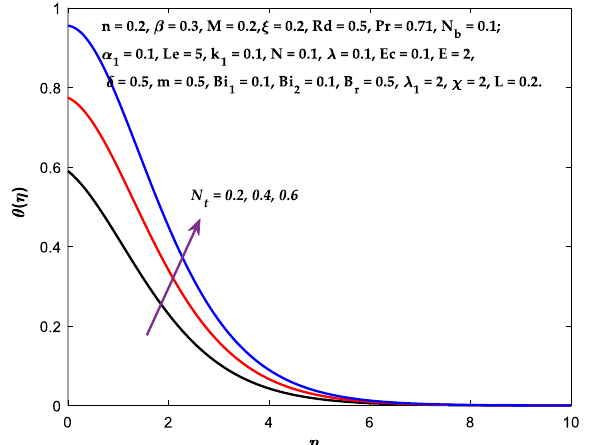
Figure 11. Diagram of N t v/s θ(η) .